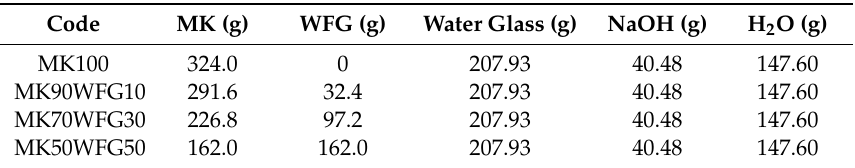
Table 2. Alkali-activated mixtures’ compositions.